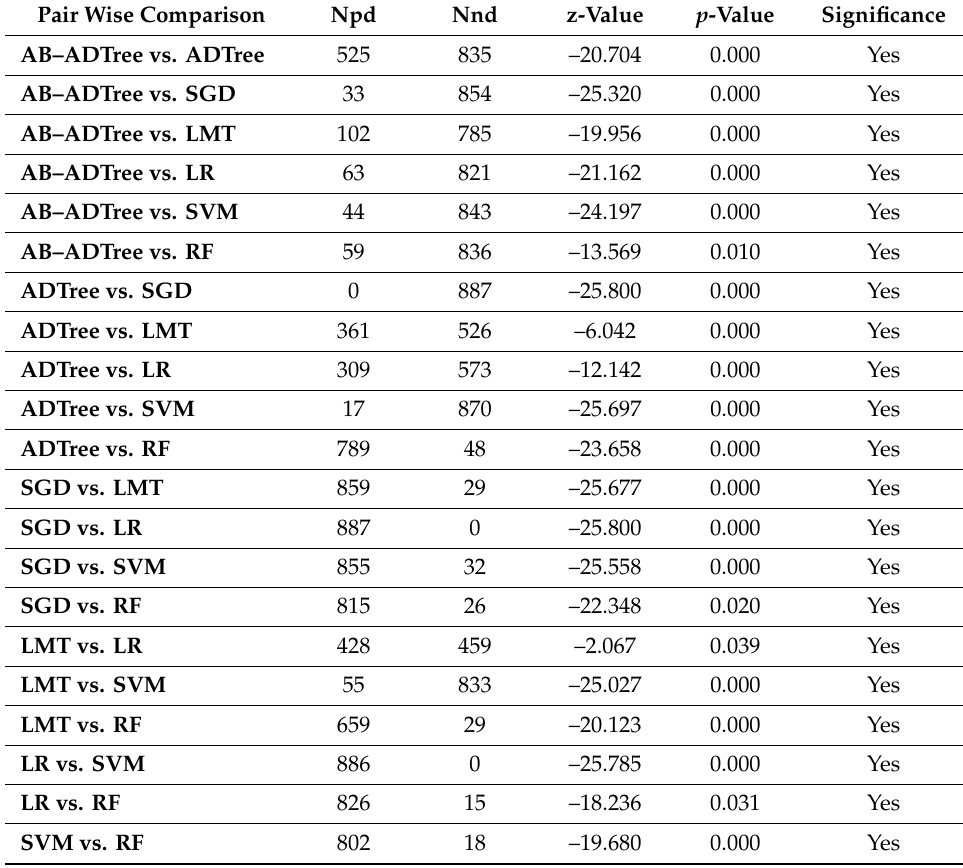
Table 7. Performance of the seven groundwater spring potential models (GSPM) using Wilcoxon sign-rank test